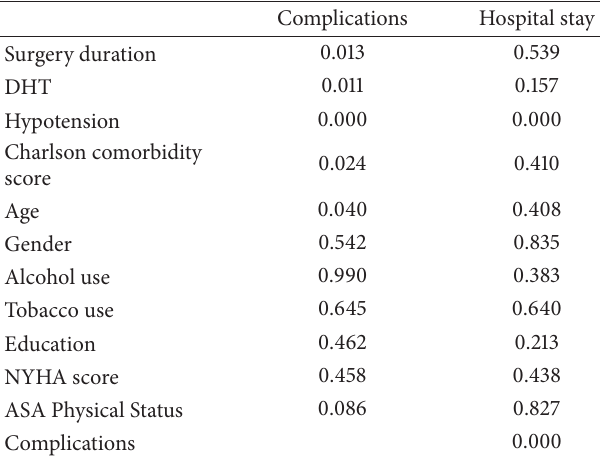
Table 3: Significance of associations with Fisher’s exact test. Listed numbers indicate 𝑃 values for each association. Associations are statistically significant when 𝑃 < 0.05 .